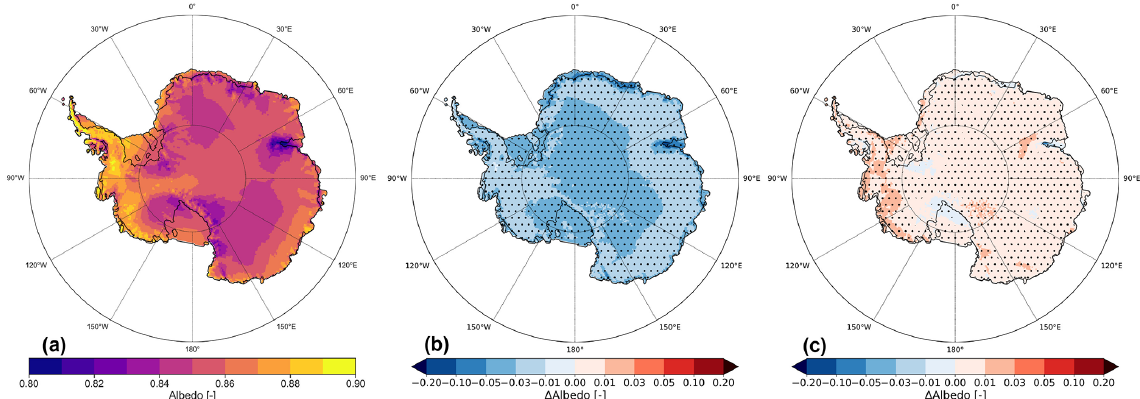
Figure 8. (a) Mean yearly-averaged albedo in CON and albedo difference with Rp2 in (b) GS and (c) CON for 1985–2018. The dots represent significance.